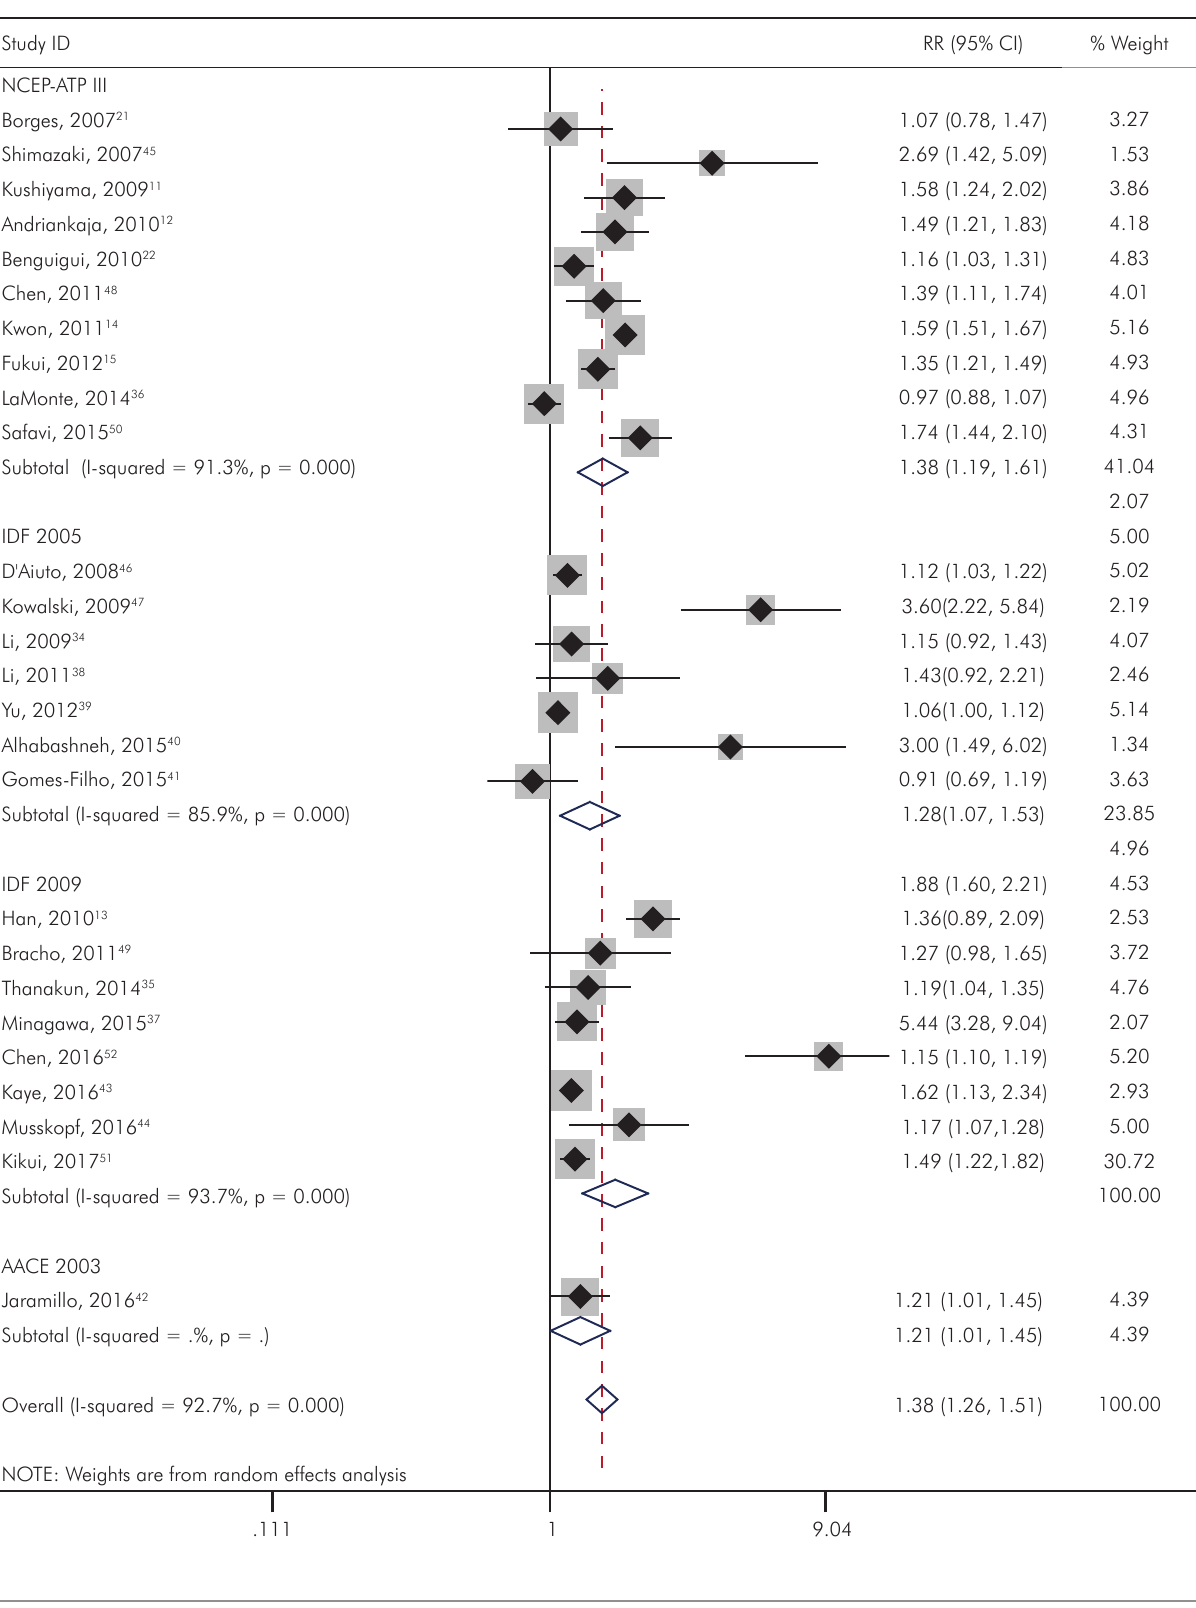
Figure 4. Subgroup analyses with criteria used for metabolic syndrome